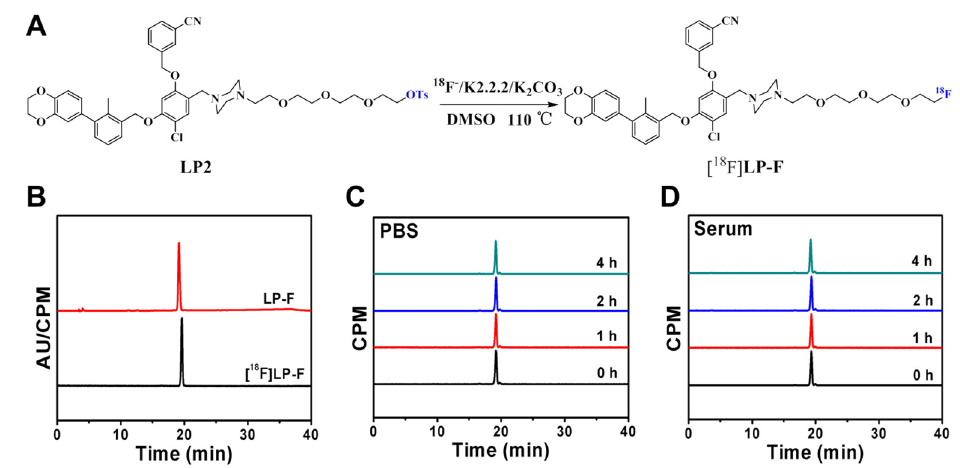
Figure 1. Radiosynthesis and HPLC characterization of the tracer [ 18 F] LP-F . ( A ) Radiosynthesis of [ 18 F] LP-F via nucleophilic substitution reaction. ( B ) HPLC analysis of [ 18 F] LP-F (radio) and LP-F (UV). (C, D) The stability of [ 18 F] LP-F in PBS ( C ) and mouse serum ( D ) at 37 °C measured by radio-HPLC.